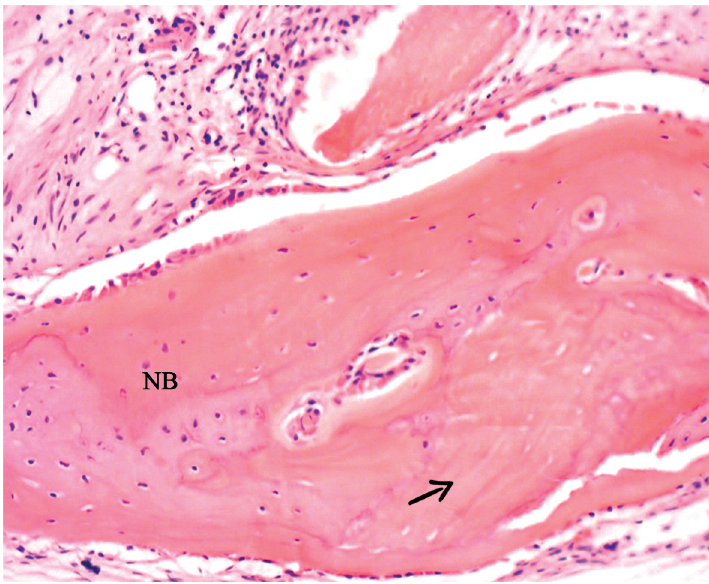
Figure 6- Group AB+PBMT: Presence of newly formed bone (NB) surrounding particle of autogenous bone (arrow)